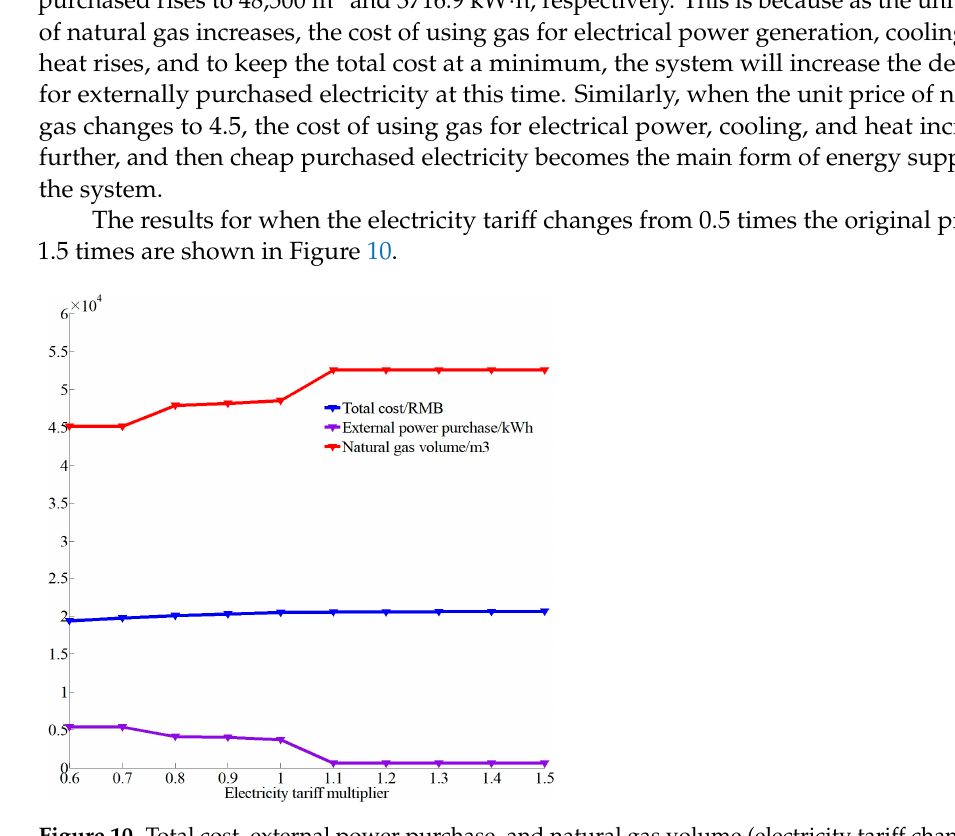
Figure 10. Total cost, external power purchase, and natural gas volume (electricity tariff changes). It can be seen that as the electricity price rises, the volume of natural gas rises, and the external power purchase gradually decreases, while the total cost remains the same. When the electricity tariff changes to 1.1 times the original tariff, the amount of external electricity purchased decreases rapidly, i.e., 588 kW·h, while the amount of natural gas increases to 52,500 m 3 . This is because as the electricity tariff increases, the system switches to using cheaper natural gas to produce electricity, heat, and cooling. In summary, when the price of natural gas and electricity changes, the system will use natural gas and externally purchased electricity according to the economic cost mini- mum, which leads to the total cost and the change of natural gas volume and externally purchased electricity.